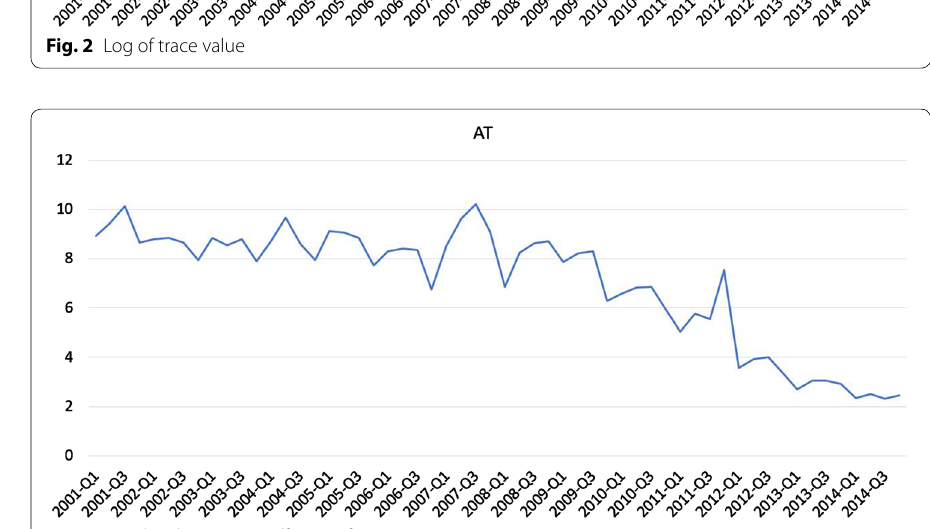
Fig. 3 Weighted average tariff rates of Japan